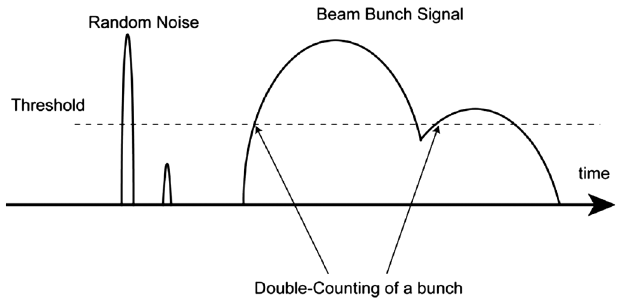
FIG. 35. Difficulties in obtaining beam bunch timing by setting a fixed threshold.